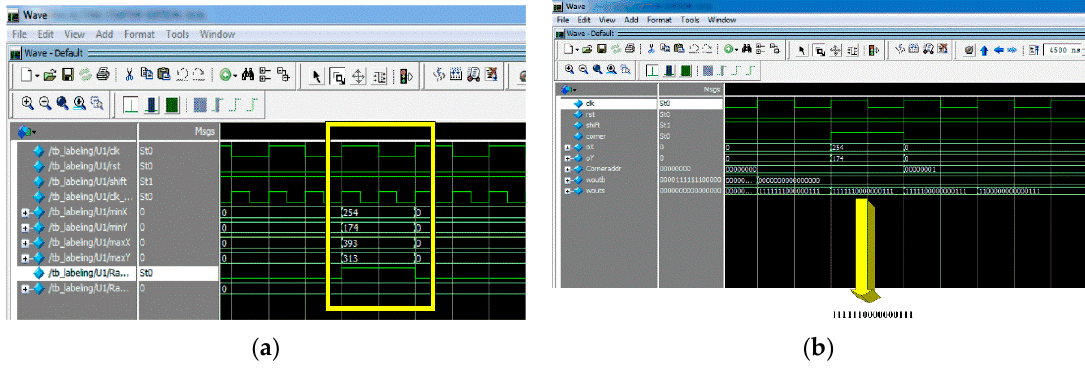
Figure 14. ( a ) Bounding box coordinates; ( b ) Corner Detection using FAST.